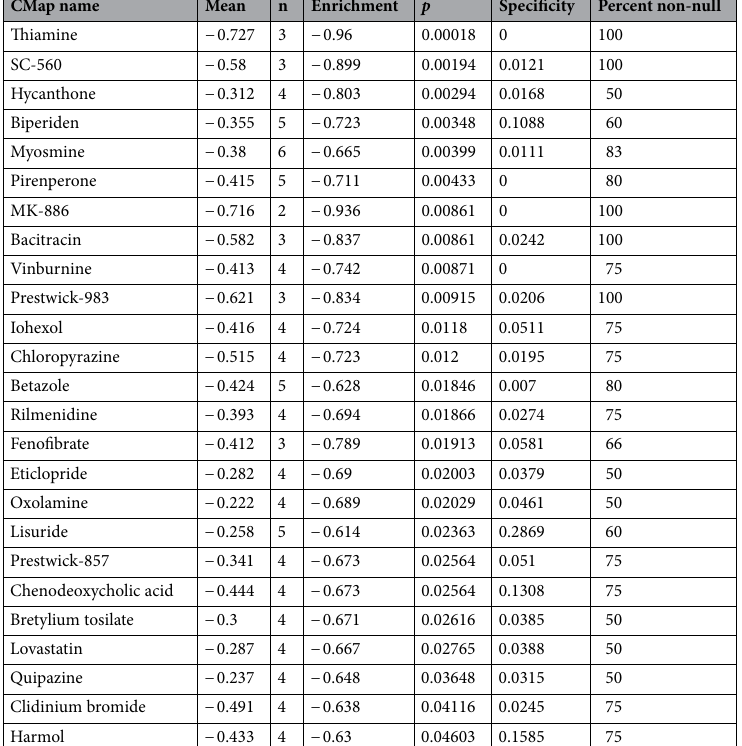
Table 1. Top chemicals correlated with up and down signatures in the connectivity map by using